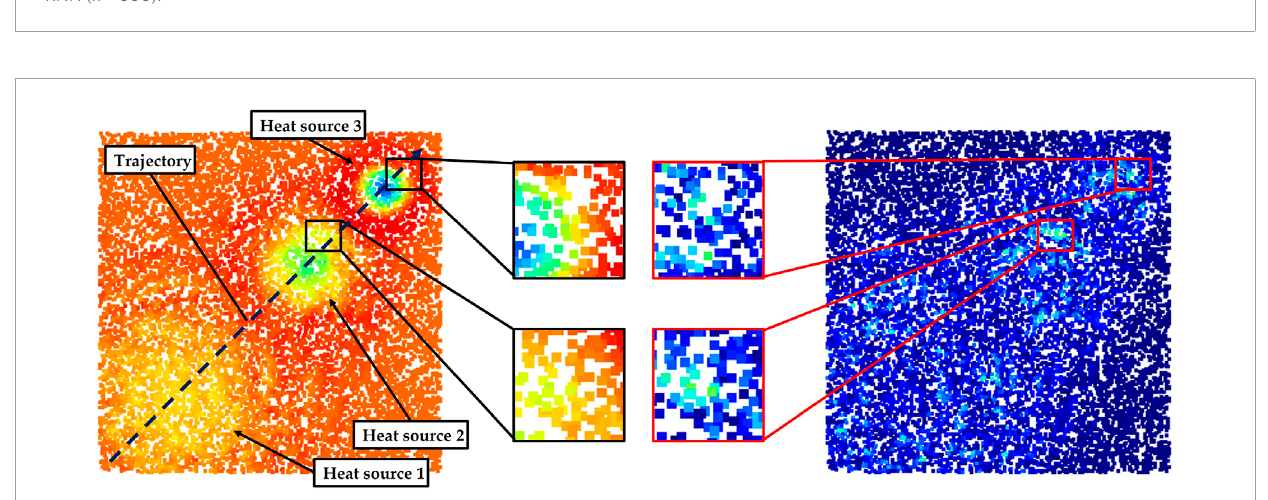
FIGURE 6 Visualization of a calculated divergence distribution (left) and the corresponding error distribution (right) using our method, where brighter points in the error distribution indicate greater errors.